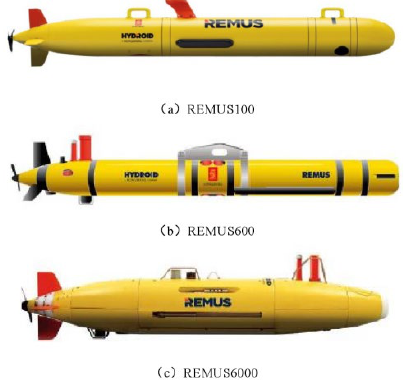
Figure 1. The REMUS series of underwater vehicles.